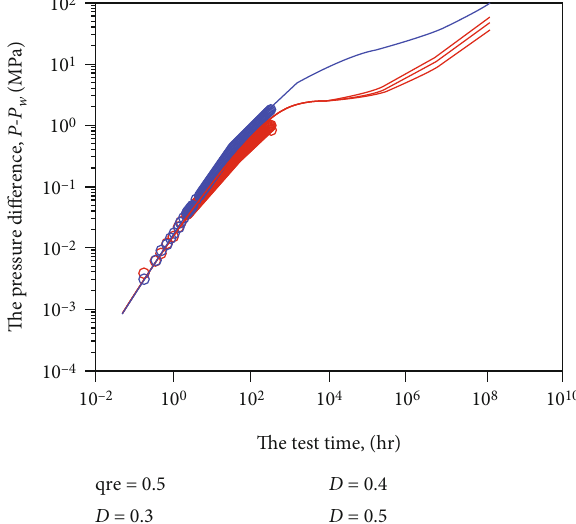
Figure 6: Water cut and its derivative change curve with dimensionless time in the presence of high-water-consumption zone.